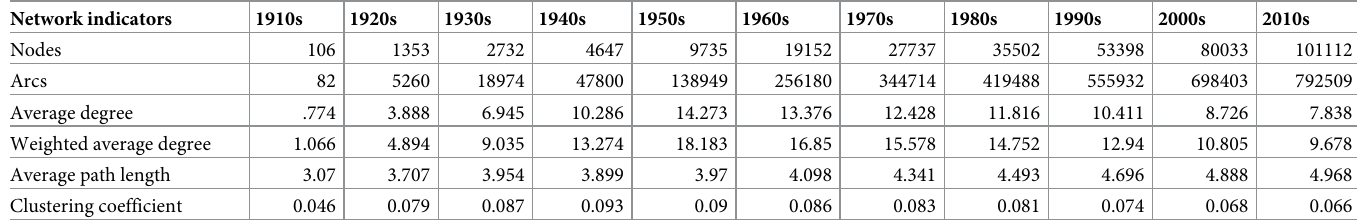
Table 1. Network indicators evolution by decade.